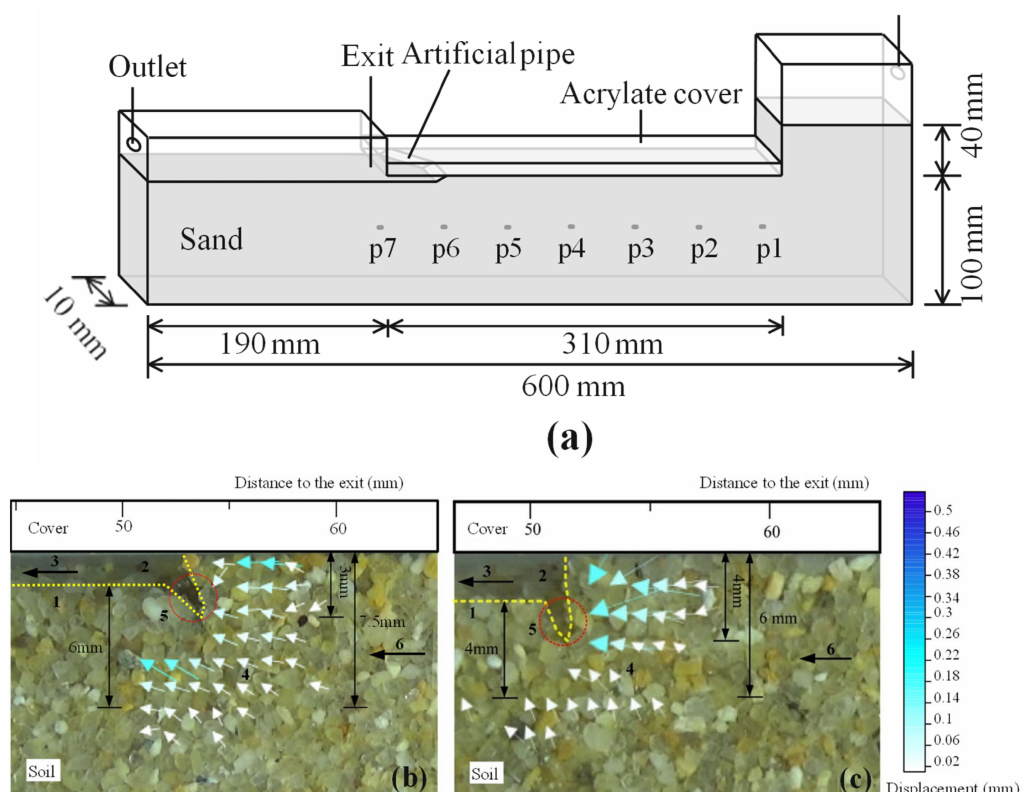
Figure 2. Example of the calculated displacement of loosened particles in the vertical section of the pipe tip in a sand experiment [32]: ( a ) overview for the experiments; ( b ) channel at equilibrium; ( c ) channel development as loosened soil is removed at the tip of the channel. 1 Pipe tip; 2 pipe flow; 3 loosened zone; 4 ditch; 5 flow